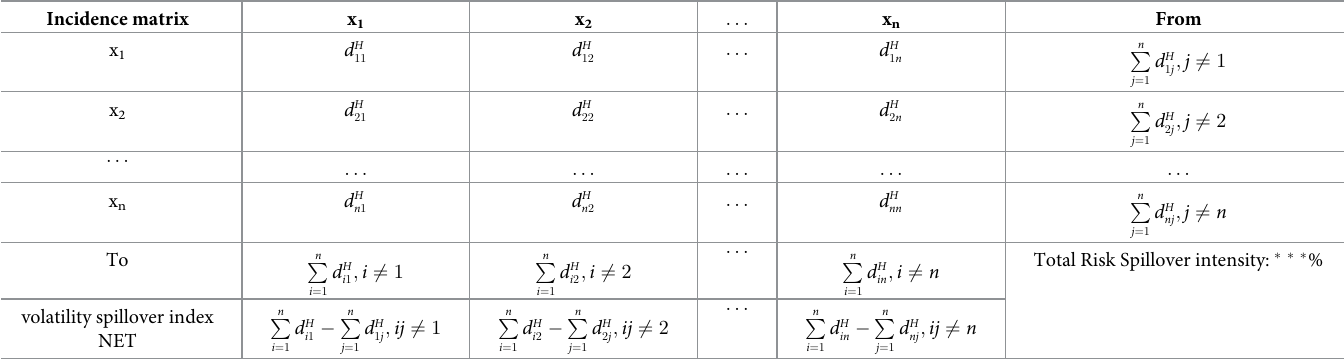
Table 8. Matrix representation of the degree of association. Incidence matrix